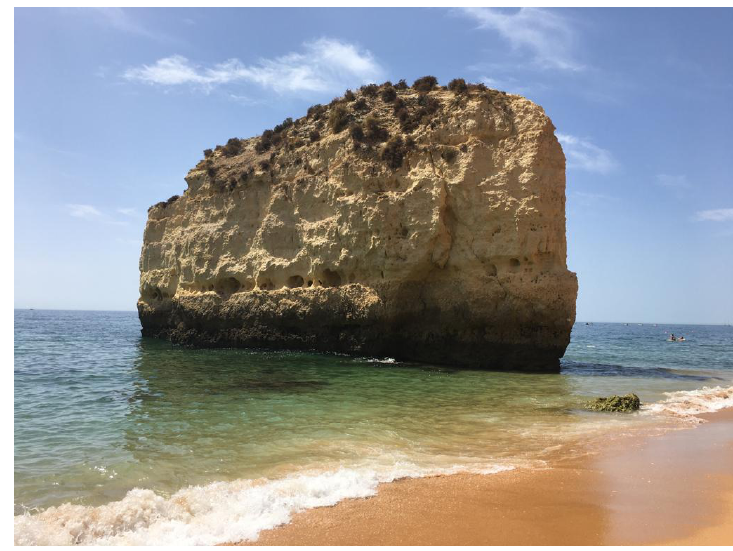
Figure 4. Aspect of the east end of Praia da Cova Redonda.